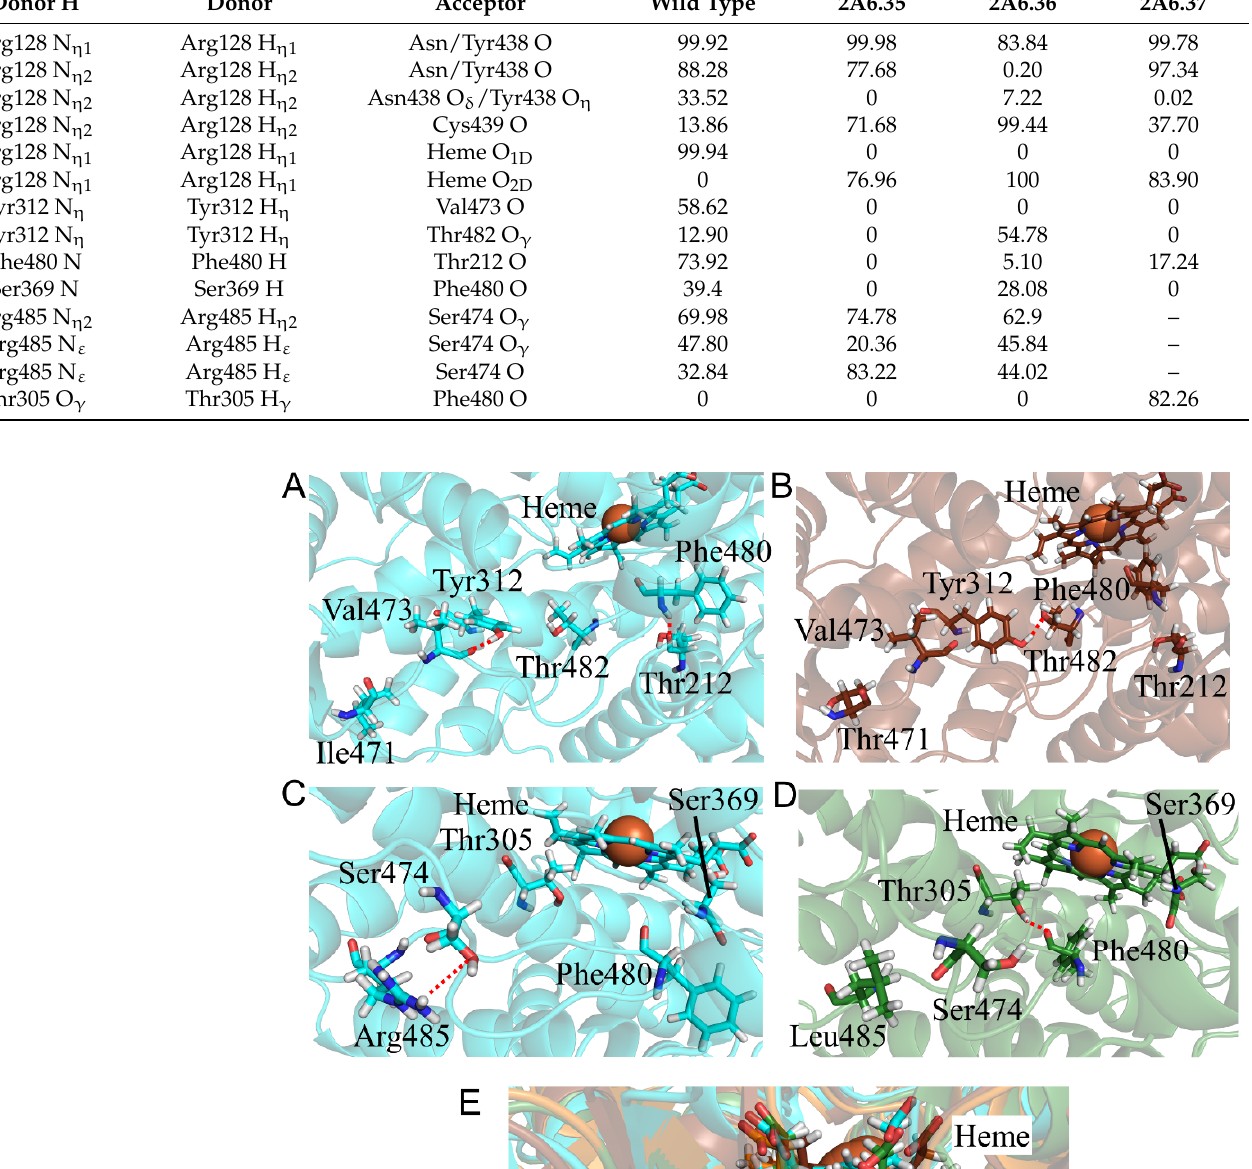
Table 7. Hydrogen bond formation involved in the structural change in CYP2A6.35, CYP2A6.36, and CYP2A6.37. Donor H